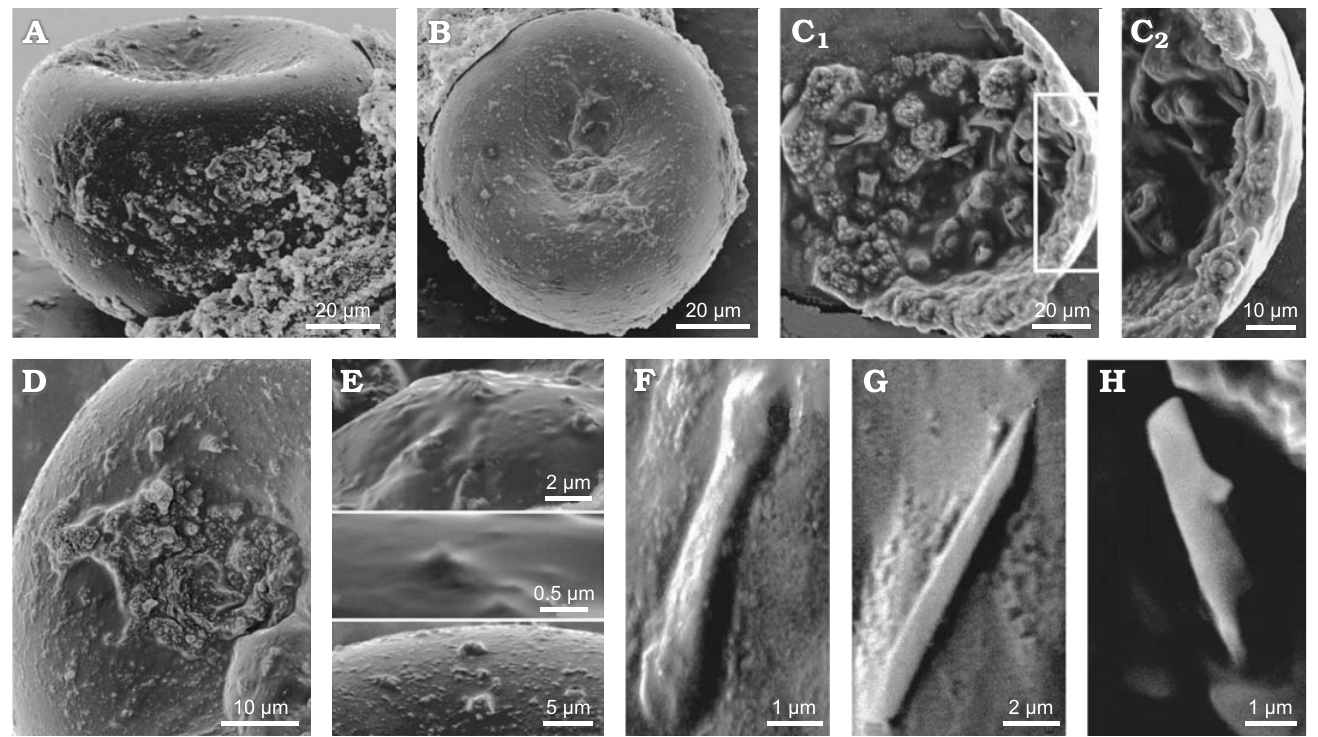
Fig. 8. Matris gemmuleanalogi Du, Wang, and Komiya, 2015, from the Ediacaran of Yangtze Gorges area, South China (originally interpreted as Ediacaran freshwater sponge but most likely representing amoebe tests). A . Gemmule-like structure in lateral view. B . Gemmule-like structure view from the top. C . Internal microstructures of a broken fossil. Gemmuloscleres-like structures are projected into the coat of the broken gemmule-like; C 2 , detail of C 1 showing three possible layers of a coat (cross-section): a thin homogeneous inner layer, a pneumatic layer-like structure embedded with gemmuloscle- res-like structure and a naked outer layer. D . Gemmule like surface with a possible gemmuloscleres protruding in the middle. E . Spine and tubercles on the gemmule-like surface. F . Short, dumbbell-like structure. G . Raphide microsclere-like structure. H . Gemmuloscleres-like structure. SEM images. Modified from Du et al.